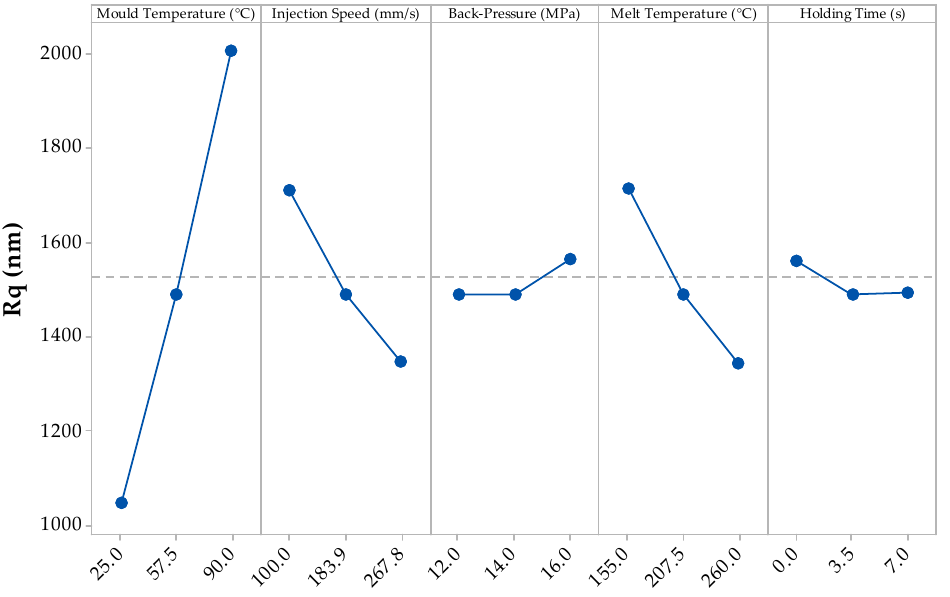
ff ects plot for the R Figure 6. Main effects plot for the R q results from the DoE. Figure 6. Main e q results from the